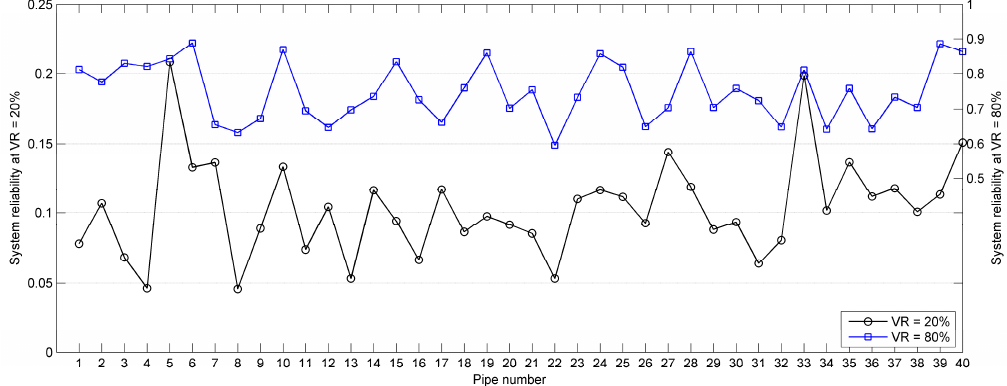
Figure 5. System reliability at VR = 20% and VR = 80%.